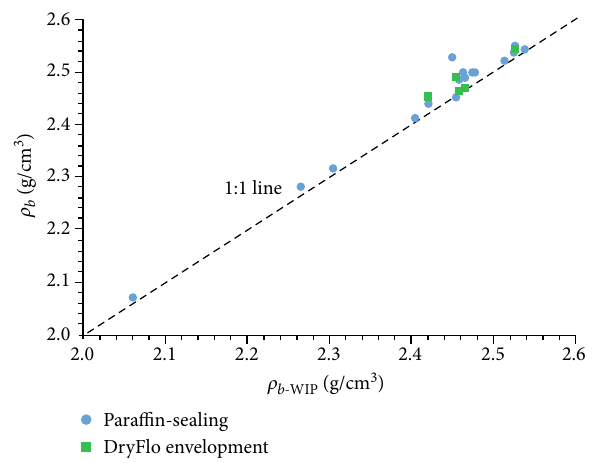
Figure 2: Comparison of bulk density measured from the WIP, para ffi n-sealing, and DryFlo-enveloping techniques; the x -axis is for bulk density from the WIP method, and the y -axis from the para ffi n-sealing and DryFlo-enveloping methods. The WIP bulk density is smaller than the other methods when the point is located above the 1:1 line.